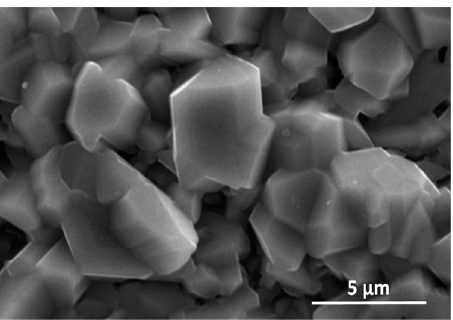
Figure 10. SEM micrograph of Ti-46Al-7Nb-0.7Cr-0.1Si-0.2Ni alloy exposed to air at 950 °C—surface